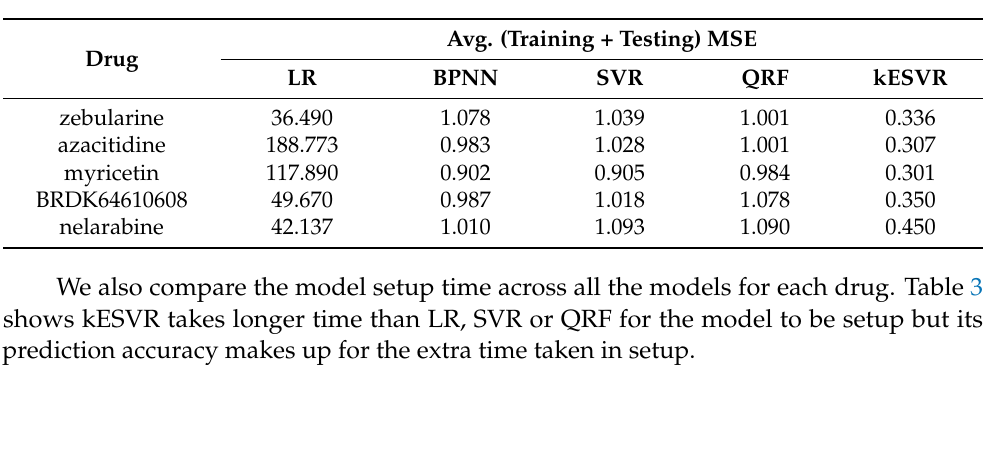
Table 2. Model comparison for 5 random